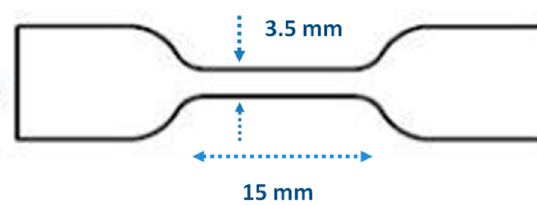
Figure 1. Dog-bone-shape specimens for the static tensile test.